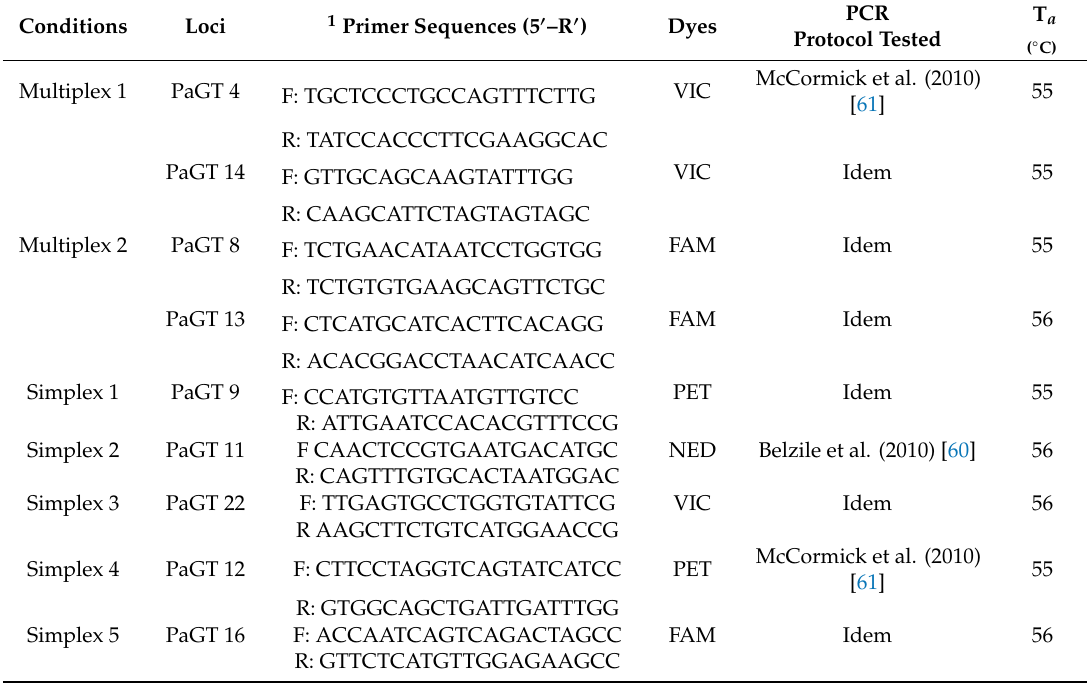
Table 8. Microsatellite loci optimized for population genetics